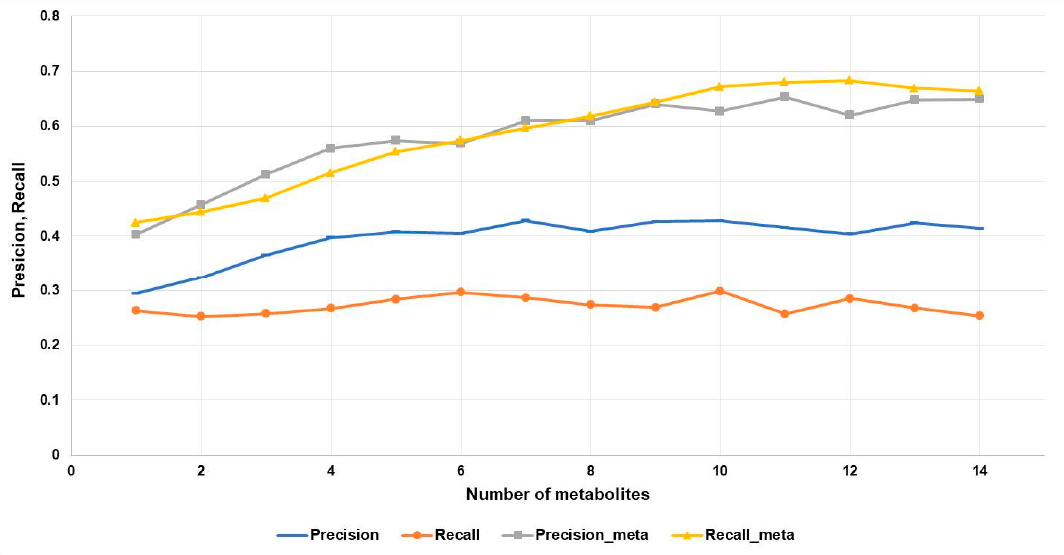
Figure 4. Accuracy metrics estimates depending on the number of metabolites for toxic and adverse Effects category at the 0.5 threshold.